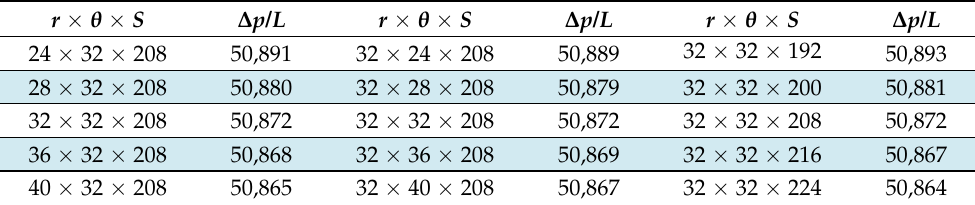
Table 1. Values of ∆ p / L when changing grid